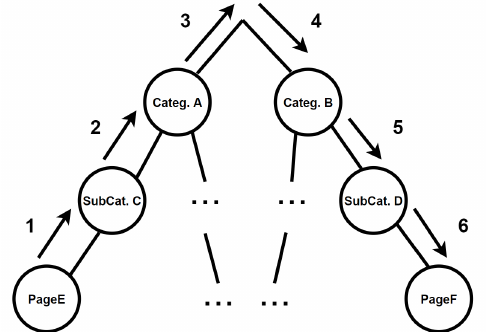
Figure 5. An illustration of Discovery calculation process with a simple example.